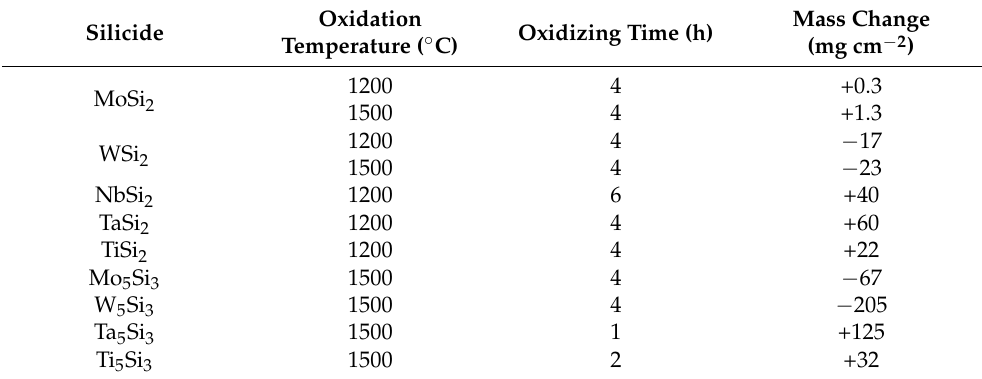
Table 5. Oxidation resistance of high melting point silicides [37].